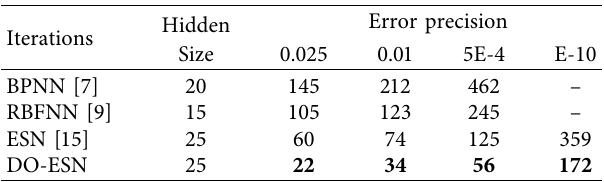
Table 1: Comparison of error precision and iterations for BPNN, RBFNN, ESN, and DO-ESN.